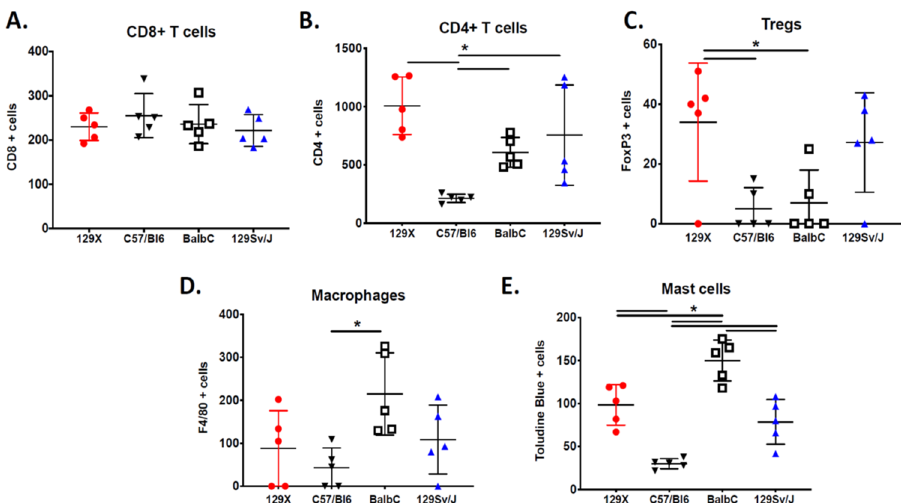
Figure 3. The MPNST immune landscape is determined by genetic background. ( A ) Levels of CD8+ T cells in terminally-harvested MPNSTs are similar across all host strains. ( B ) Infiltration of CD4+ T cells are significantly lower in tumors from C57BL/6 mice compared to MPNSTs in mice from 129X1, BALB/c, and 129/SvJae backgrounds. ( C ) Foxp3+ Tregs are detected at higher levels in tumors from 129X1 mice compared to C57BL/6 and BALB/c mice. ( D ) MPNSTs from BALB/c mice have significantly higher levels of infiltrating F4/80+ macrophages compared to C57BL/6 mice. ( E ) Mast cell infiltration is higher in tumors from BALB/c mice compared to 129/SvJae, C57BL/6, and 129X1 mice. Mast cell levels are lowest in MPNSTs from C57BL/6 mice. 129X1 (red circles), C57BL/6 (black triangles), BABL/c (white squares), and 129/SvJae (blue triangles). Analyzed by one-way ANOVA with Tukey’s multiple comparison test. A p -value of less than 0.05 is considered statistically significant and is denoted by “*” ( n = 5 tumors per strain).